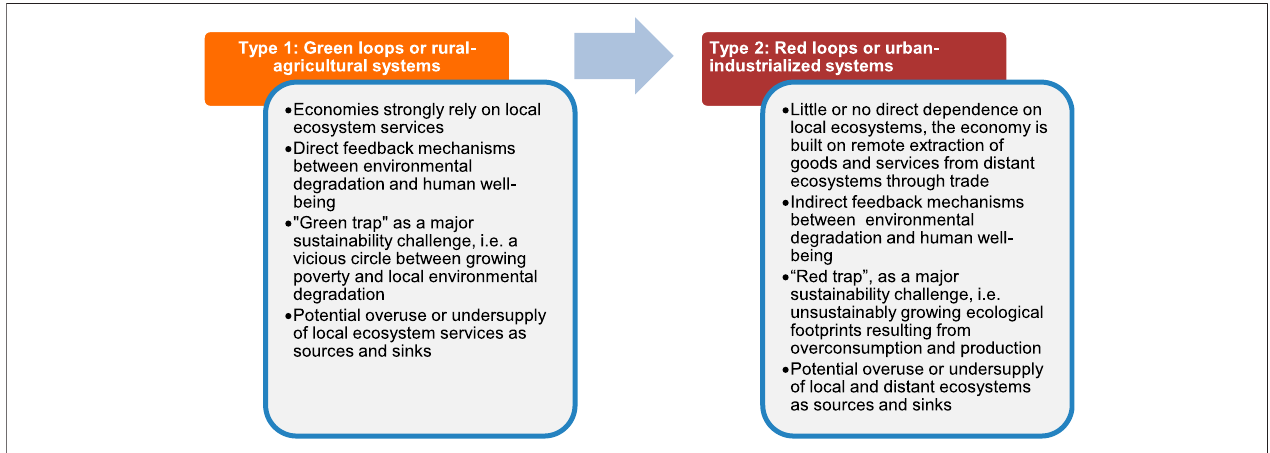
FIGURE 1 | Characteristics of green and red loops and related sustainability challenges. Based on Cumming et al. (2014) and Hamann et al. (2015).